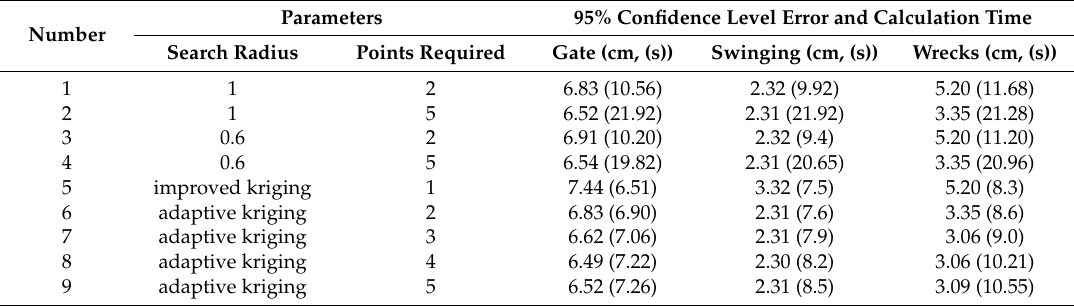
Table 2. The comparison of the modified kriging and ordinary kriging results (95% confidence level error and